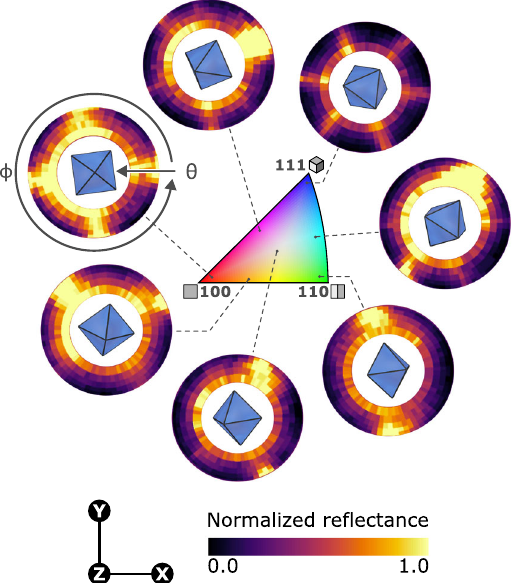
Fig. 2 Directional re fl ectance signals in I718. Directional re fl ec- tance signals measured from differently oriented grains exhibit different re fl ectance peaks. Each re fl ectance pattern is connected to its corresponding crystallographic orientation along the Z-axis (i.e., the sample surface normal) in the inverse pole fi gure (IPF) triangle. The peaks occur at illumination angles that coincide with specular re fl ections from {111} γ crystallographic